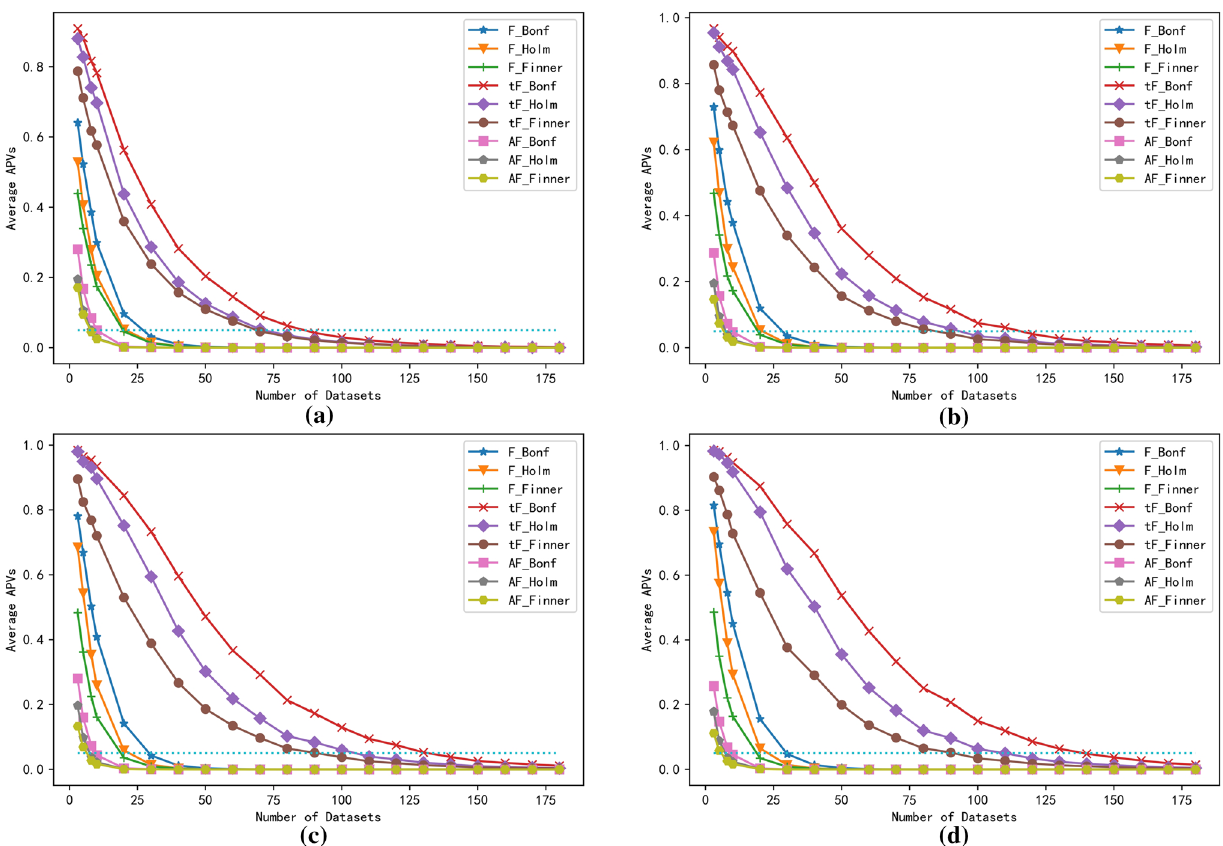
Fig. 4 Average APVs of different nonparametric statistical tests under the experiment setting i: a the number of algorithms K = 4; b K = 6; c K = 8; d K =